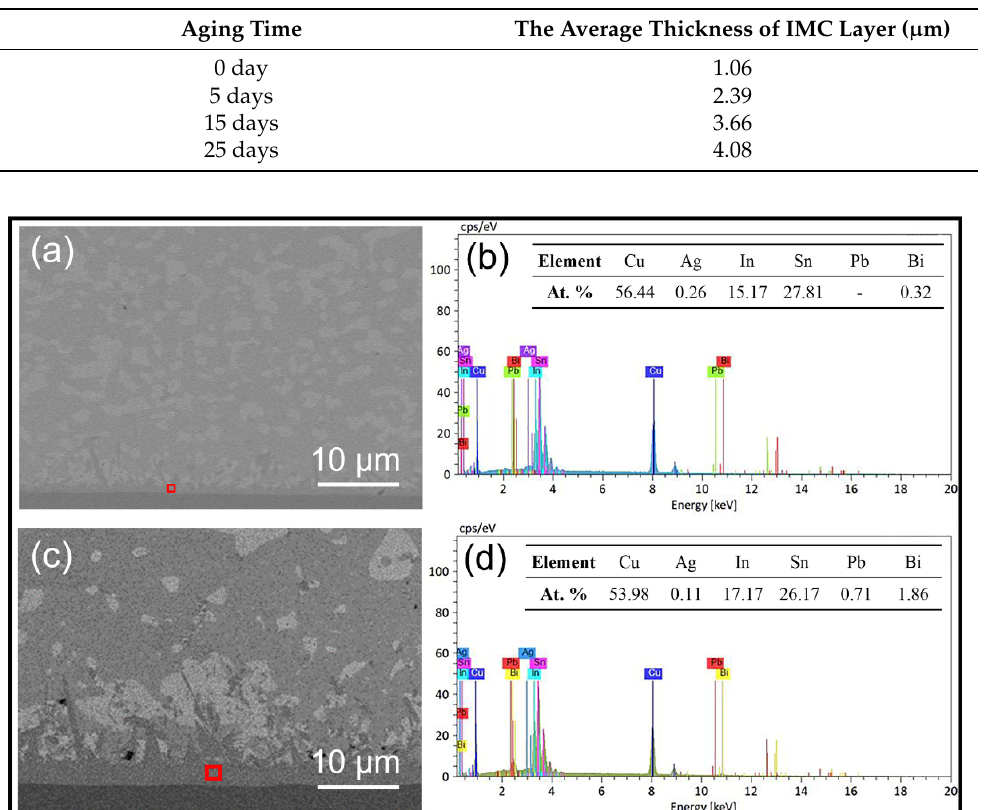
Figure 13. Elemental distribution and atomic percentage results of fully mixed solder joint after 25 days of aging. We put the results of XRD analysis before and after aging together for comparison, as shown in Figure 14. The main components of the phases before aging and after aging remain the same, which are the γ -phase and Bi 3 In 5 phase. Figures 13 and 14 demonstrate that the microstructure of the mixed solder joint is stable after aging.